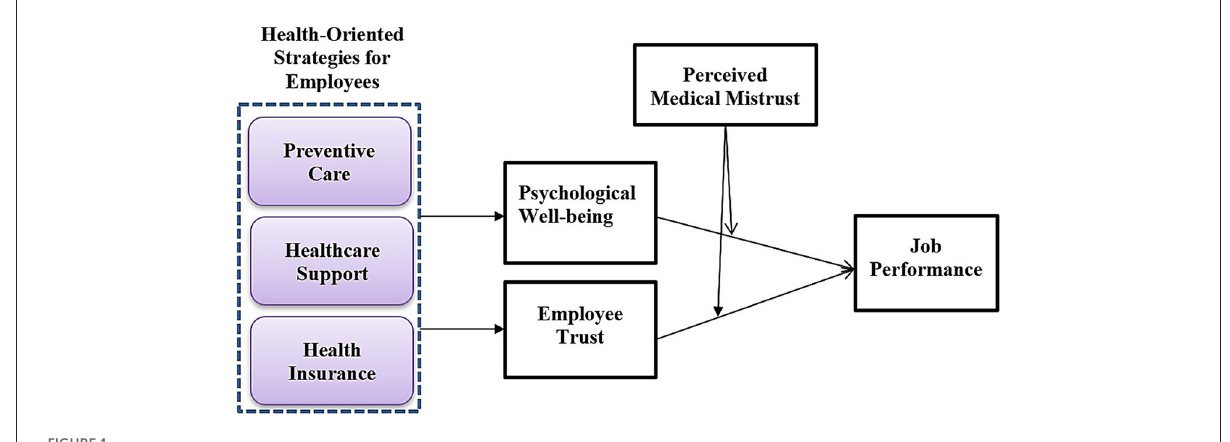
FIGURE1 Conceptual